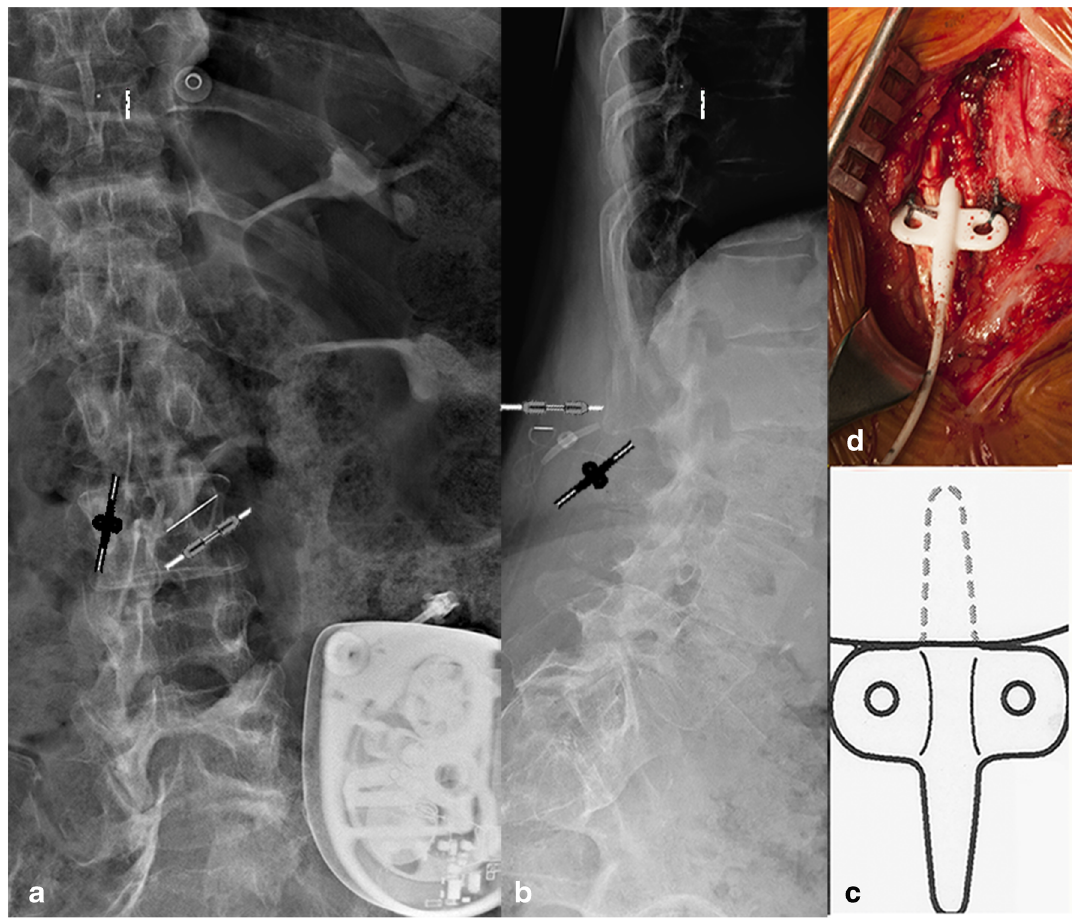
Fig. 3 Anterior-posterior (a) and lateral ( b ) plain radiography of the lumbar spine, in vivo image ( d ) and artist rendering ( c ) of the typical unfolded fixation anchor of the Ascenda catheter. The small diameter